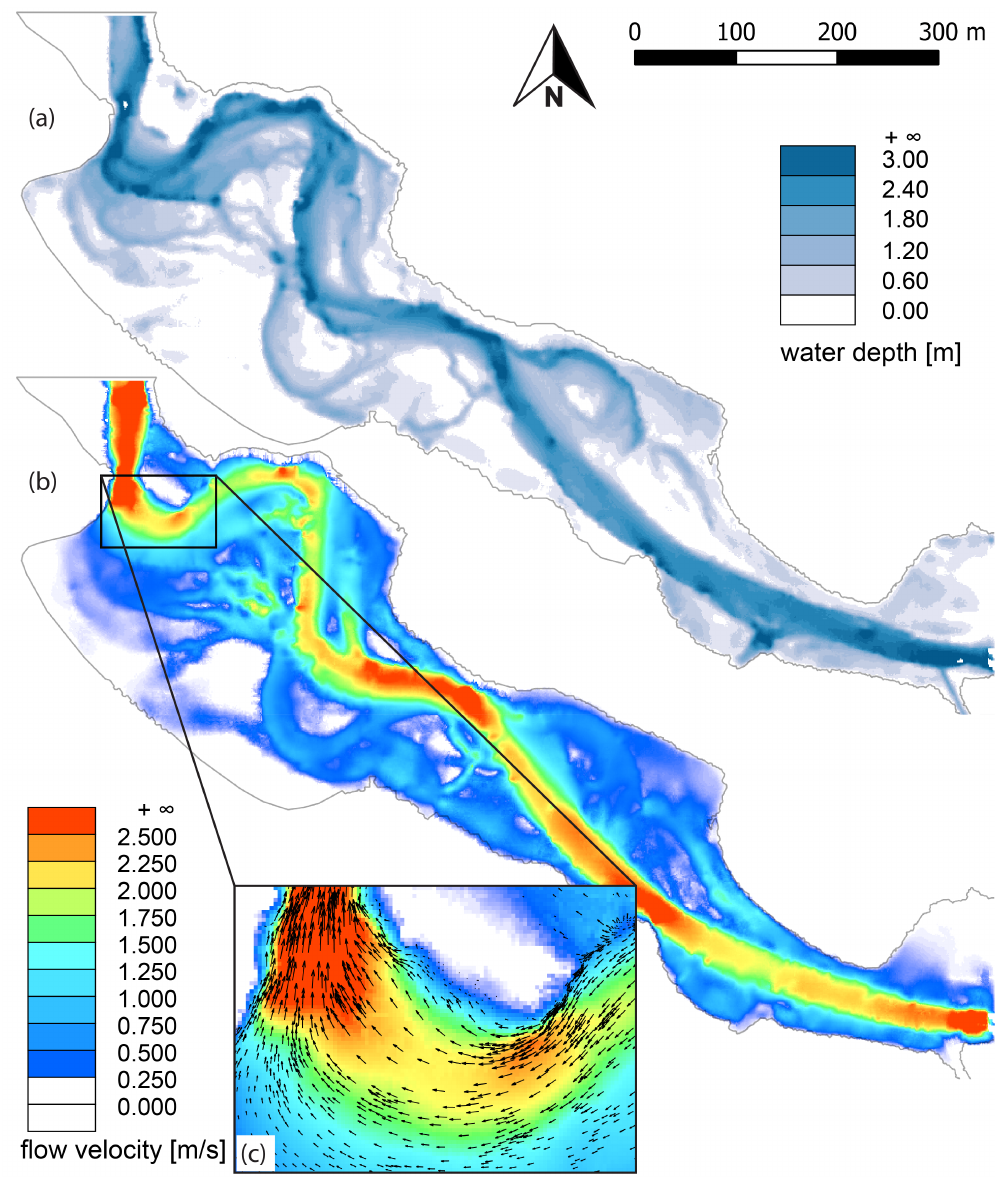
Figure 12. Results of two-dimensional depth-averaged hydrodynamic-numerical modeling at the Pielach River based on the annual flood discharge as hydrological input (136 m 3 · s − 1 ) for ( a ) water depth; ( b ) depth-averaged flow velocities; ( c ) detail including flow